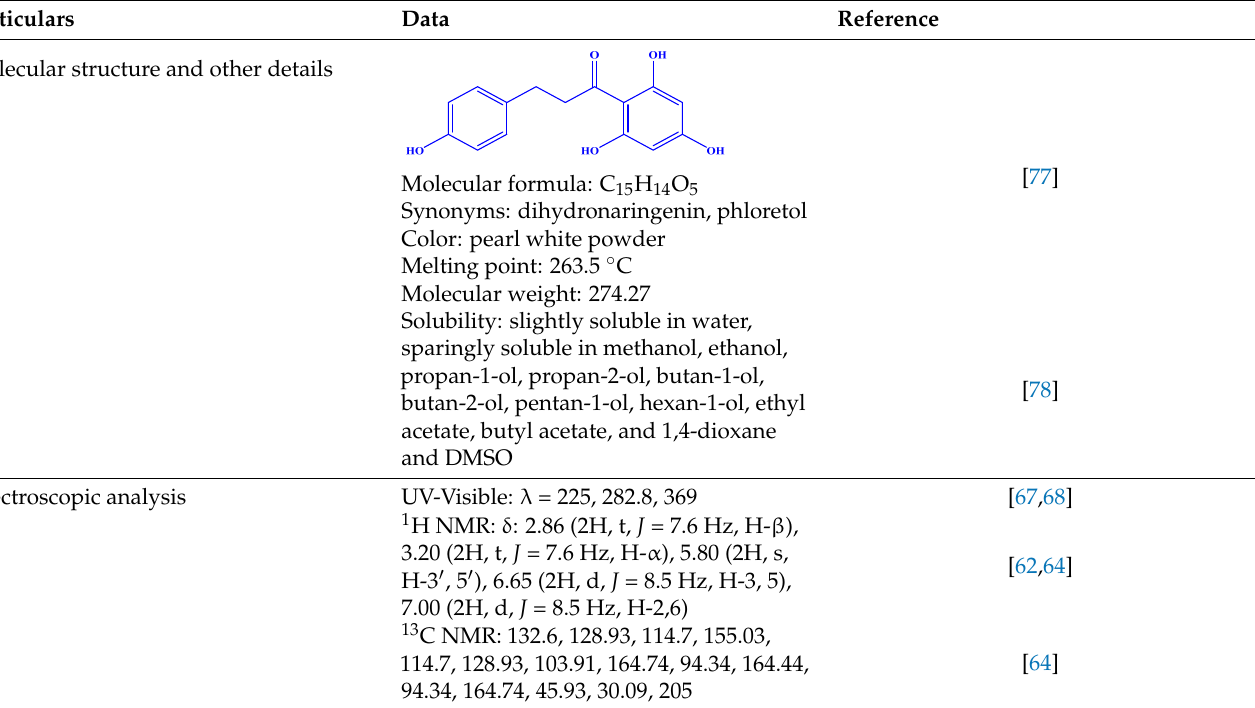
Table 2. Molecular structure and other physiochemical details of phloretin.